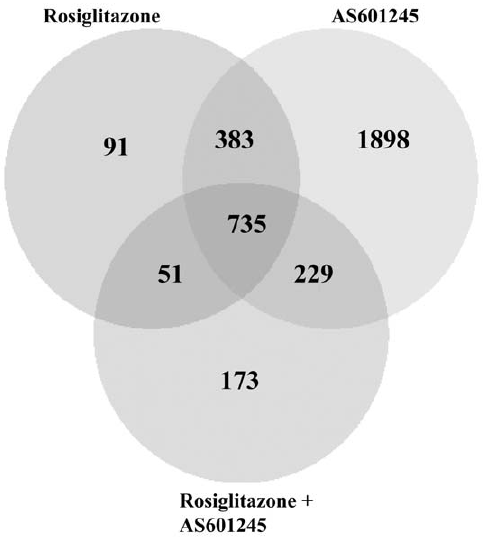
Figure 4. Venn Diagram. Gene expression in CaCo-2 cells treated with 50 m M rosiglitazone, 0.1 m M AS601245 and the association of these two compounds (Rosiglitazone + AS601245) was detected by micro- array analysis 24 hours after the treatment. Venn diagram shows the number of genes modulated by the treatments.